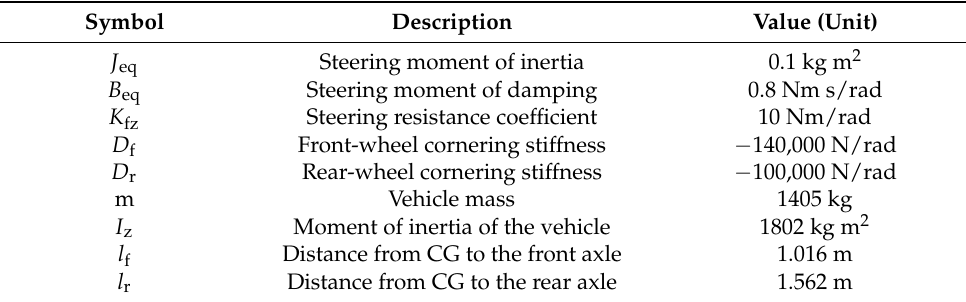
Table 1. Parameters of the combinatorial dynamic model. Symbol Description Value